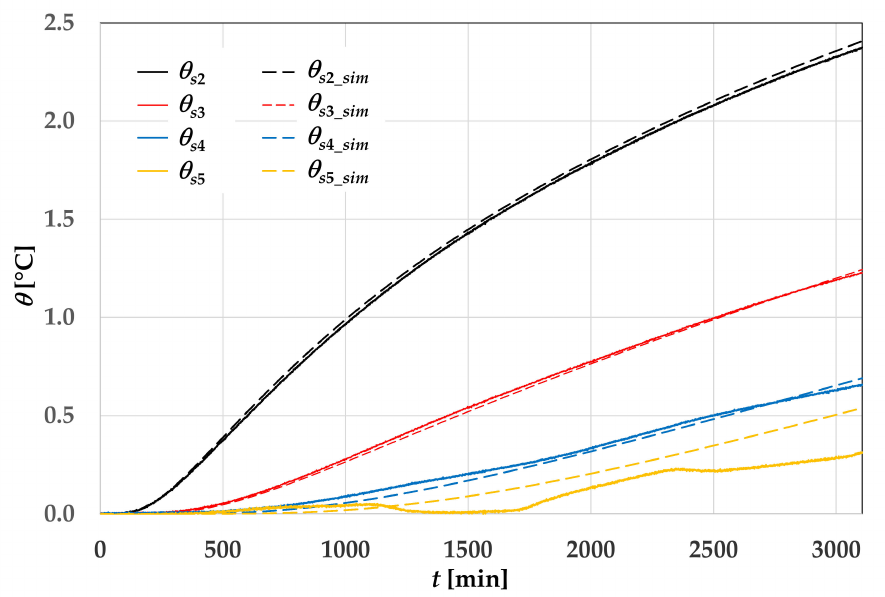
Figure 9. Time evolution of the sand temperature rise in the locations of the sensors: experimental values ( θ s 2 , θ s 3 , θ s 4 , and θ s 5 ) and simulated values ( θ s 2_ sim , θ s 3_ sim , θ s 4_ sim , and θ s 5_ sim